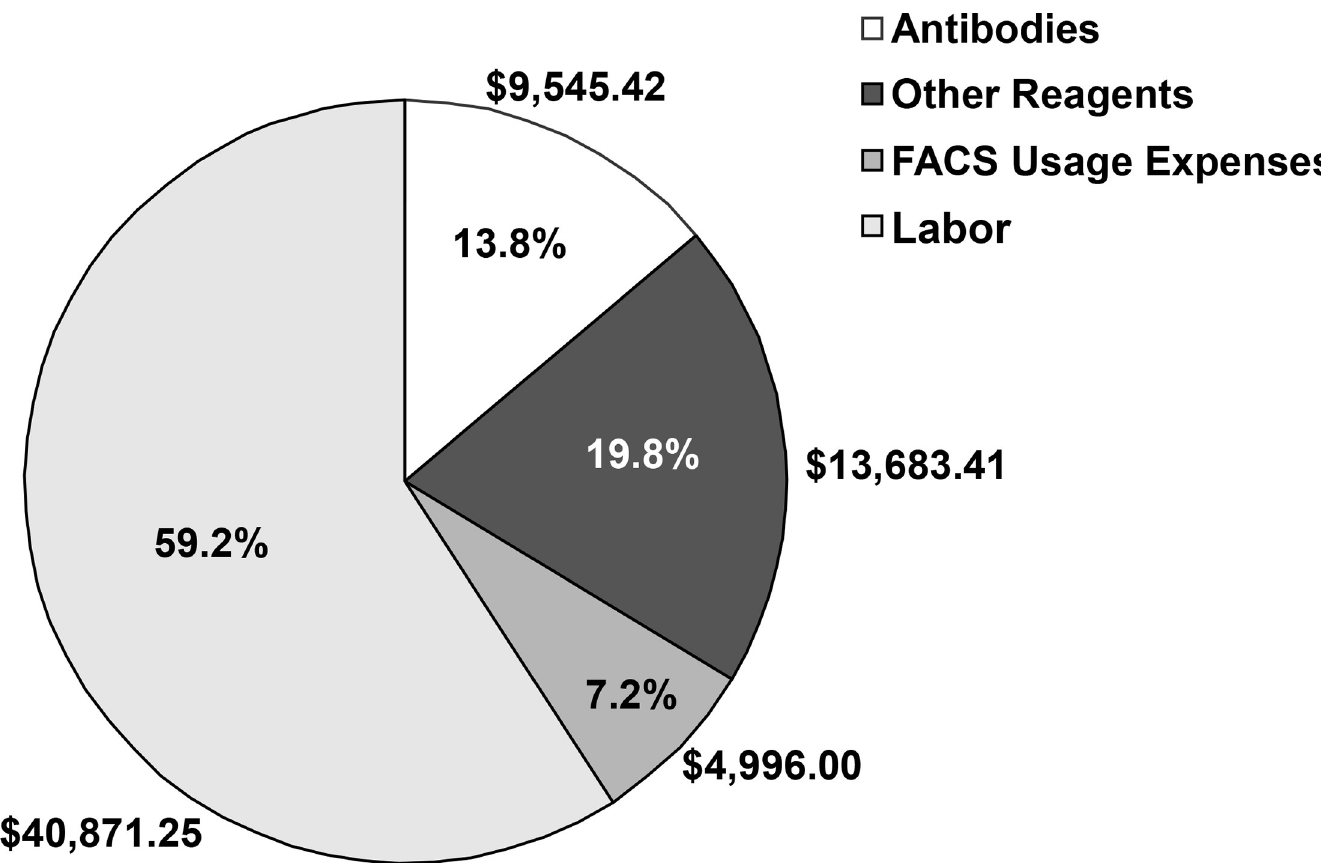
Fig 6. Reagent, personnel, and equipment costs attributable to the validation of commercial biomaterials. Distribution of expenses attributable to the validation of commercial products used in the isolation of rat pulmonary microvascular endothelial cells. FACS, fluorescence-activated cell sorting.